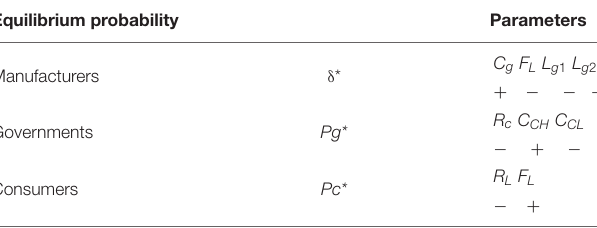
TABLE 4 | Changes in equilibrium probability as model parameters increase. Equilibrium probability